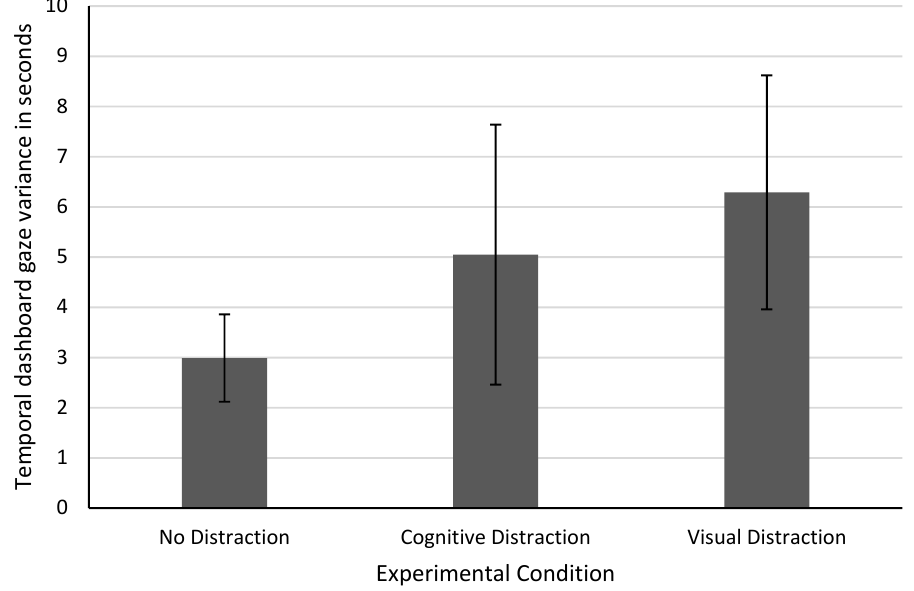
Figure 5. Average temporal dashboard gaze variance over all participants sorted by experimental segments. The error bars represent the standard deviation across different participants.